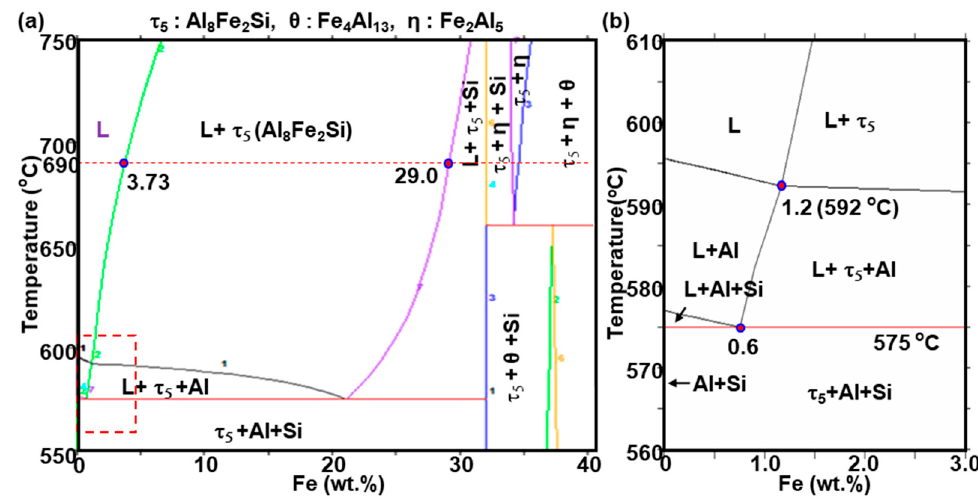
Figure 3. ( a ) Vertical section (isopleth) of the (Al–Si–Fe) ternary system, calculated with Thermo-Calc Al database version 6.0 (TCAL6). The silicon (Si) is kept constant at 10 wt % and the content of Fe is ranged with 0–40 wt %. ( b ) Its magnified region denoted as rectangular area.